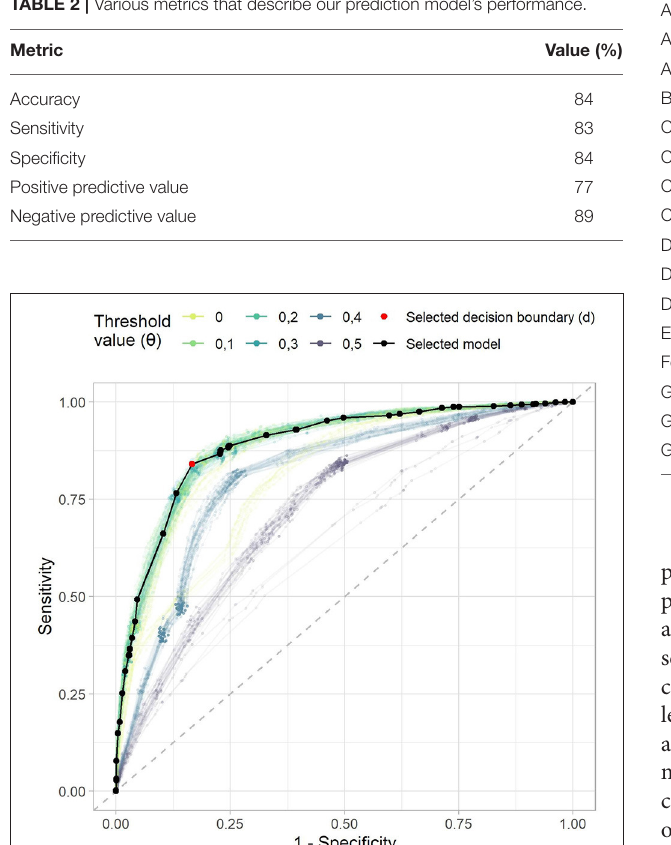
TABLE 2 | Various metrics that describe our prediction model’s performance.